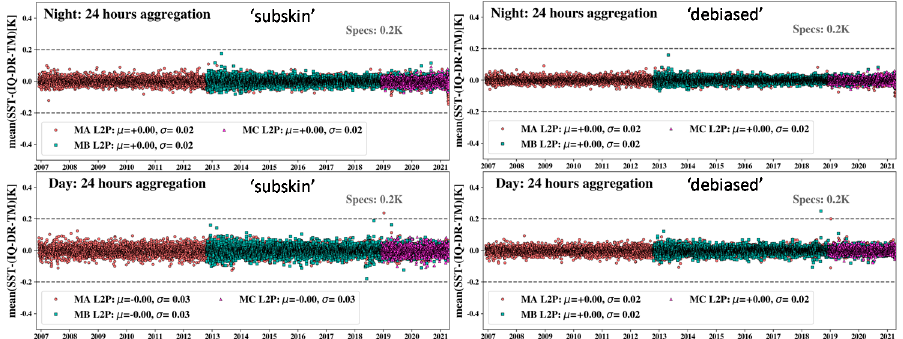
Figure 9. Time series of 24-hr aggregated ACSPO - (D+TM) SST global mean biases. ( Top ) night; ( bottom ) day; ( left ) GR; ( right ) PWR.